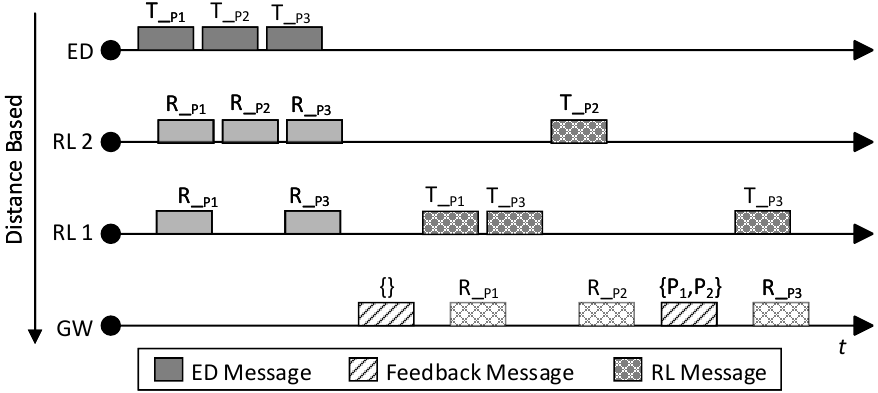
Figure 4. Example to illustrate transmission priority and feedback